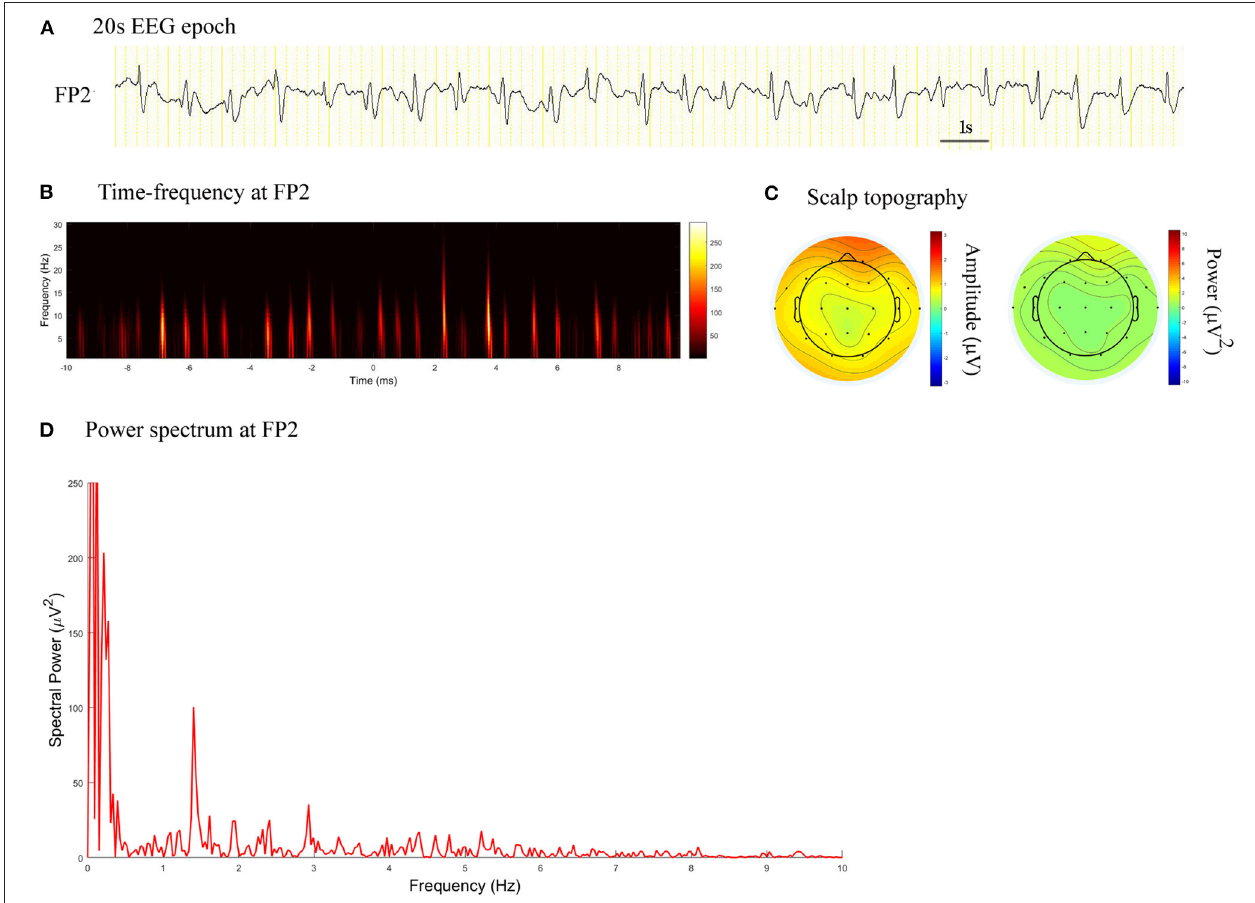
FIGURE 1 | EEG epoch, time-frequency and power spectrum analysis, and scalp topography in a patient with CJD. (A) A 20s EEG epoch at FP2 electrode. (B) Time-frequency analysis showed the PDs pattern had a frequency of 1.4Hz. (C) Scalp topography showed the PDs pattern located in the right frontal pole. (D) Spectral power value for PDs of 20s at 1.4Hz was 100.5 µ V 2